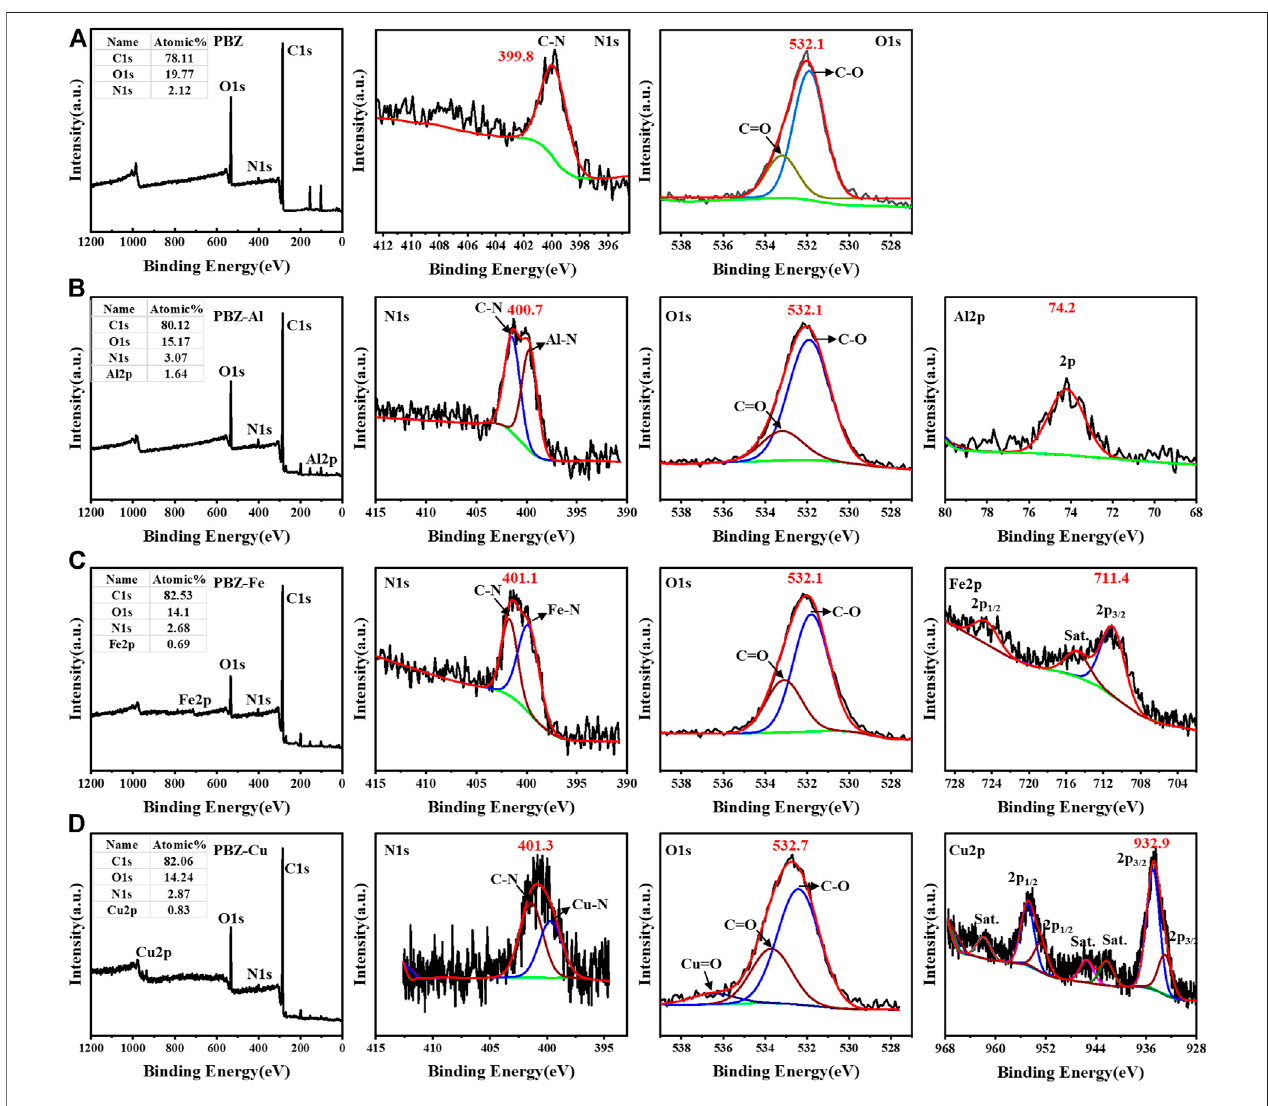
FIGURE 4 | Xps of the PBZ (A) and PBZ-M (B – D) .